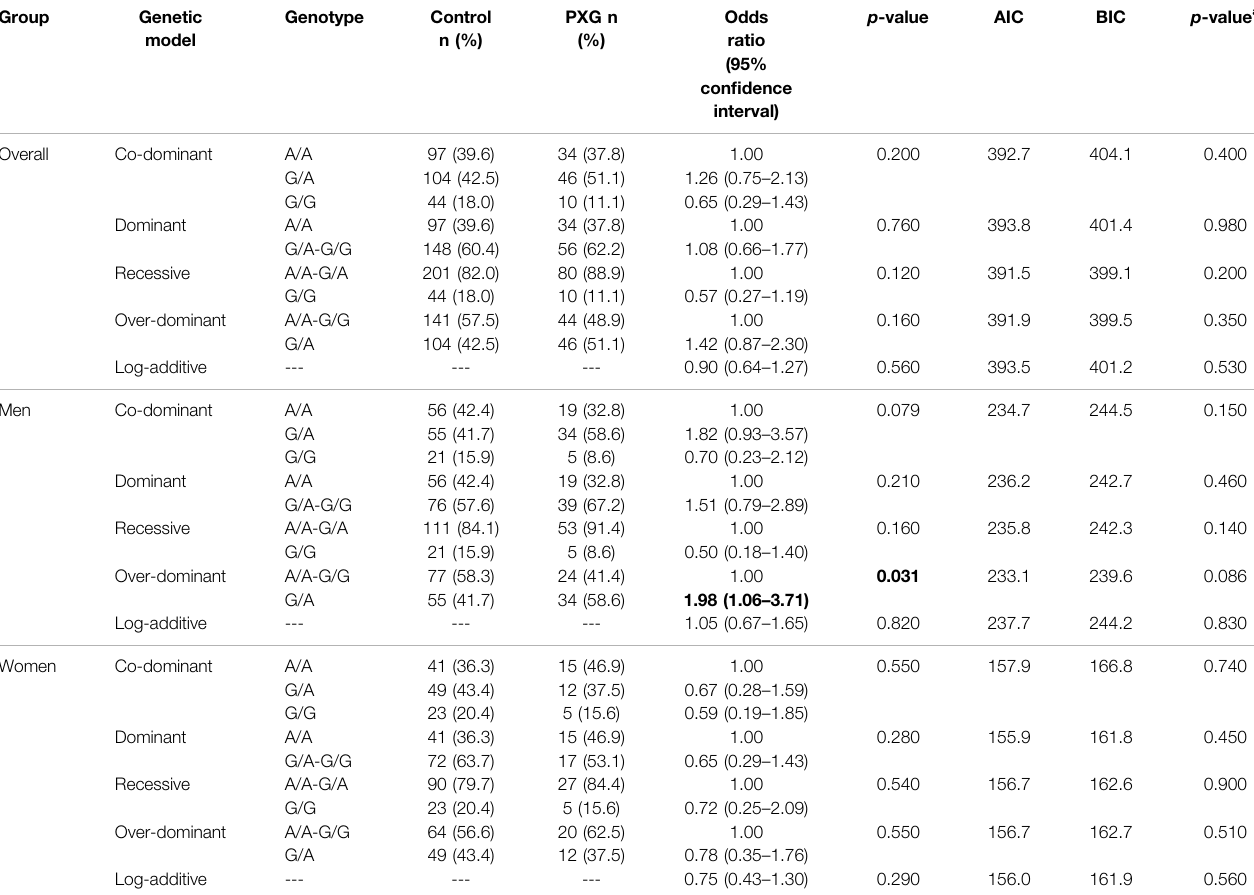
TABLE 3 | Genotype association analysis of polymorphism rs2472493 in ABCA1 in pseudoexfoliation glaucoma. Group Genetic model